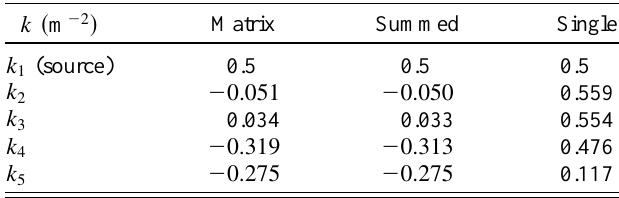
TABLE I. Compensator strengths ( k 2 2 5 ) in the presence of the coupling source k 1 using the single-turn matrix compensa- tion and the summed- and single-resonance